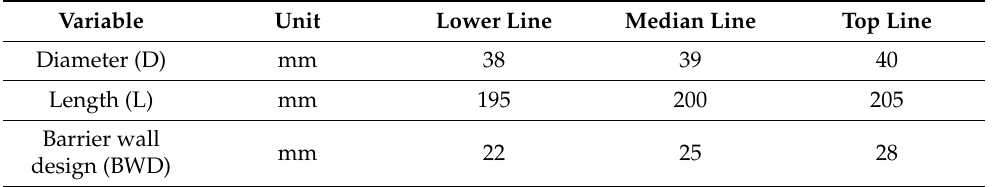
Table 4. The variable value range of preforming die.